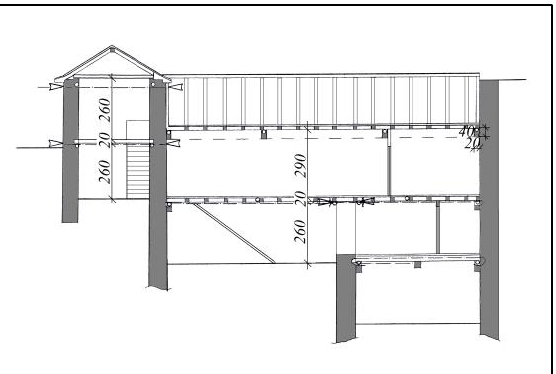
Figure 24. At their ends, the rods were anchored to the 10 mm thick steel plates. Figure 24. Cross-section—Positioning of tie-beams at each floor level.